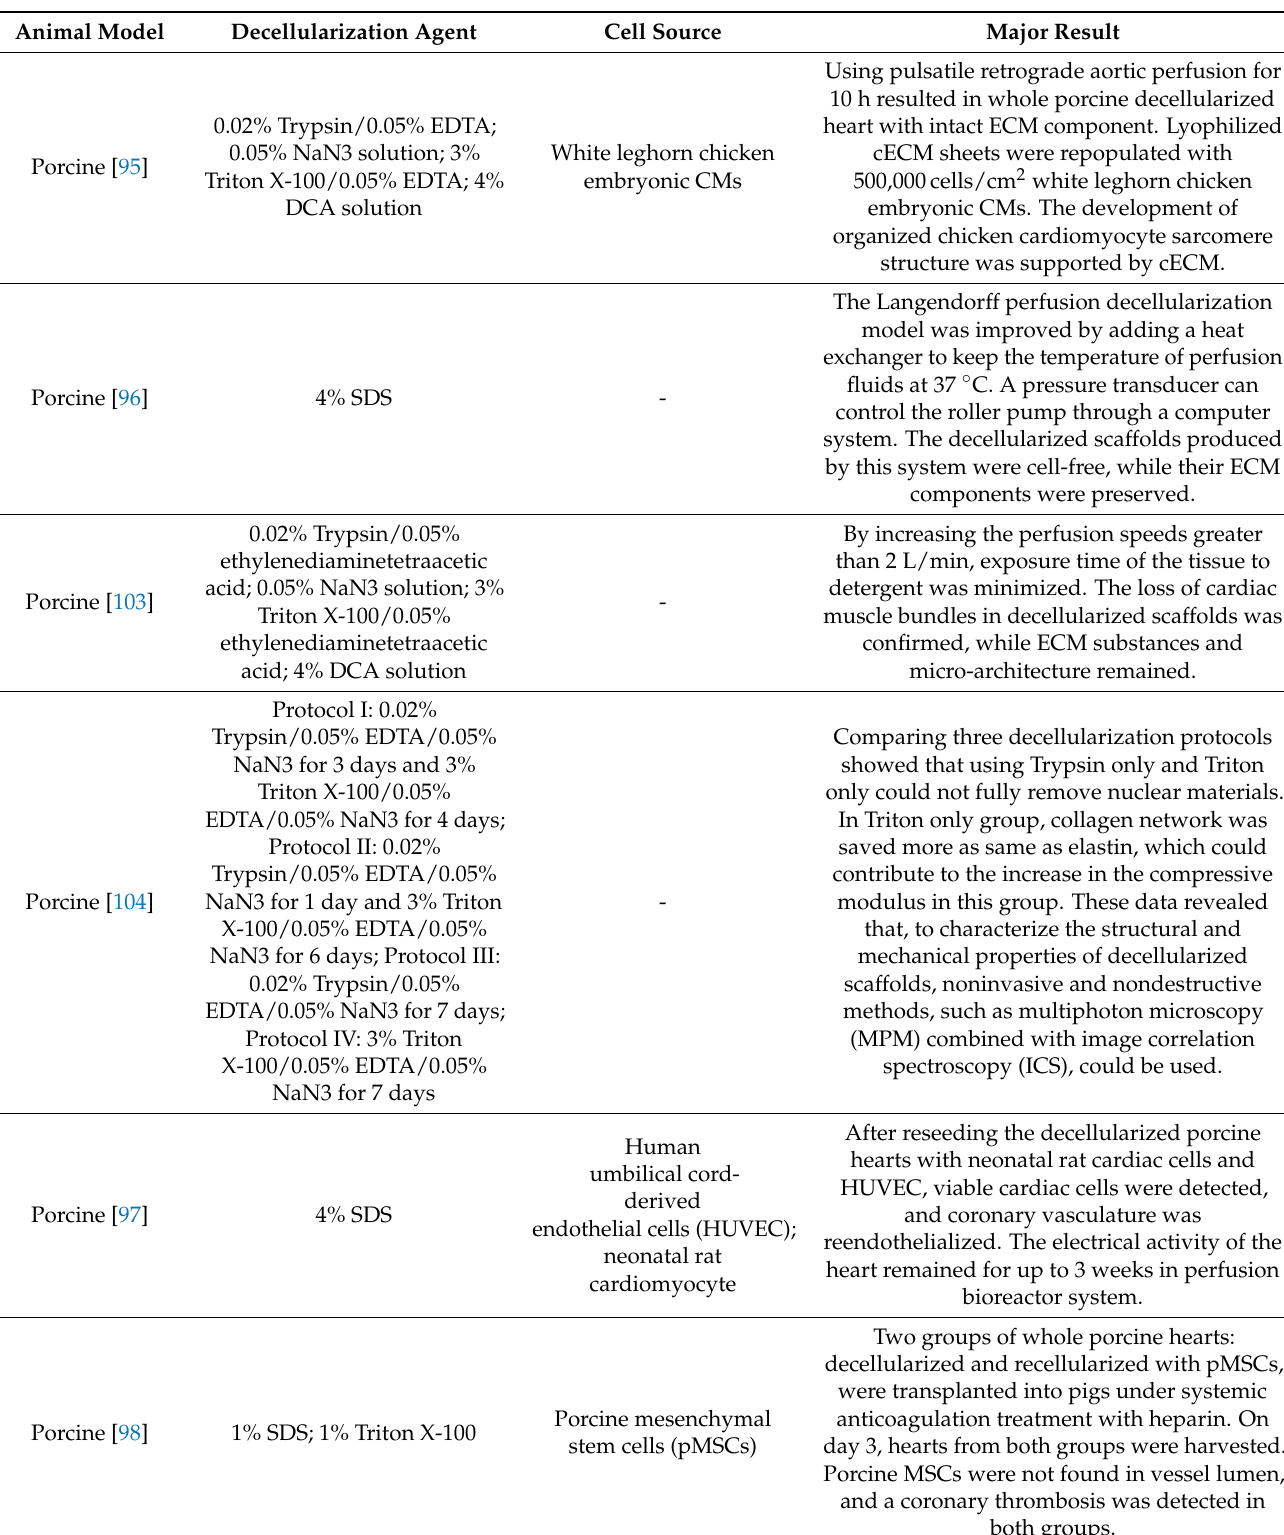
Table 2. Porcine/ovine whole-heart